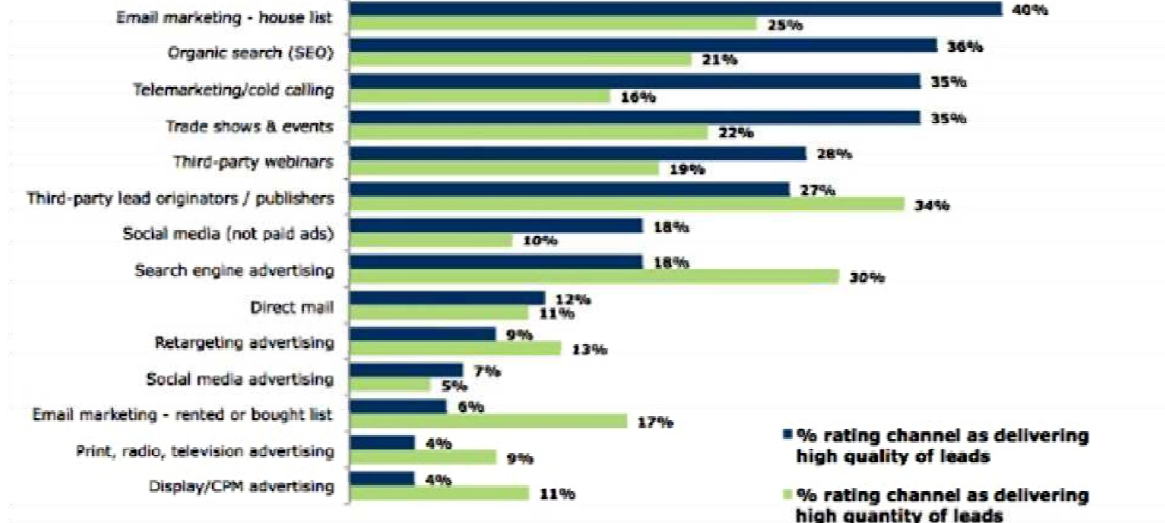
Fig. 1. Businesses opinions on lead quality and quantity by